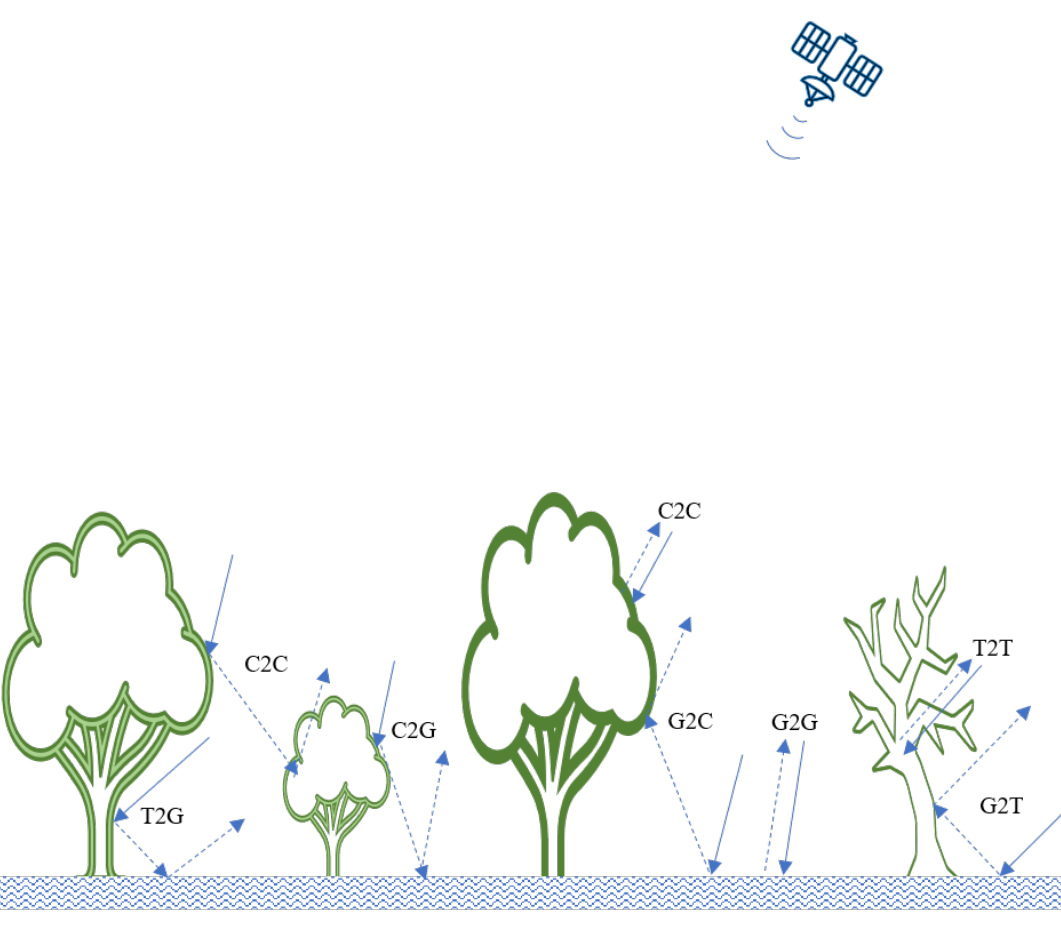
Figure 3. Radar principal backscattering responses in forests [43]: (1) Scattering from trunk to ground (T2G) and from ground to trunk (G2T); (2) scattering from canopy to ground (C2G) and from ground to canopy (G2C); (3) canopy volume scattering (C2C); (4) direct scattering from ground (G2G); and (5) direct scattering from tree trunks